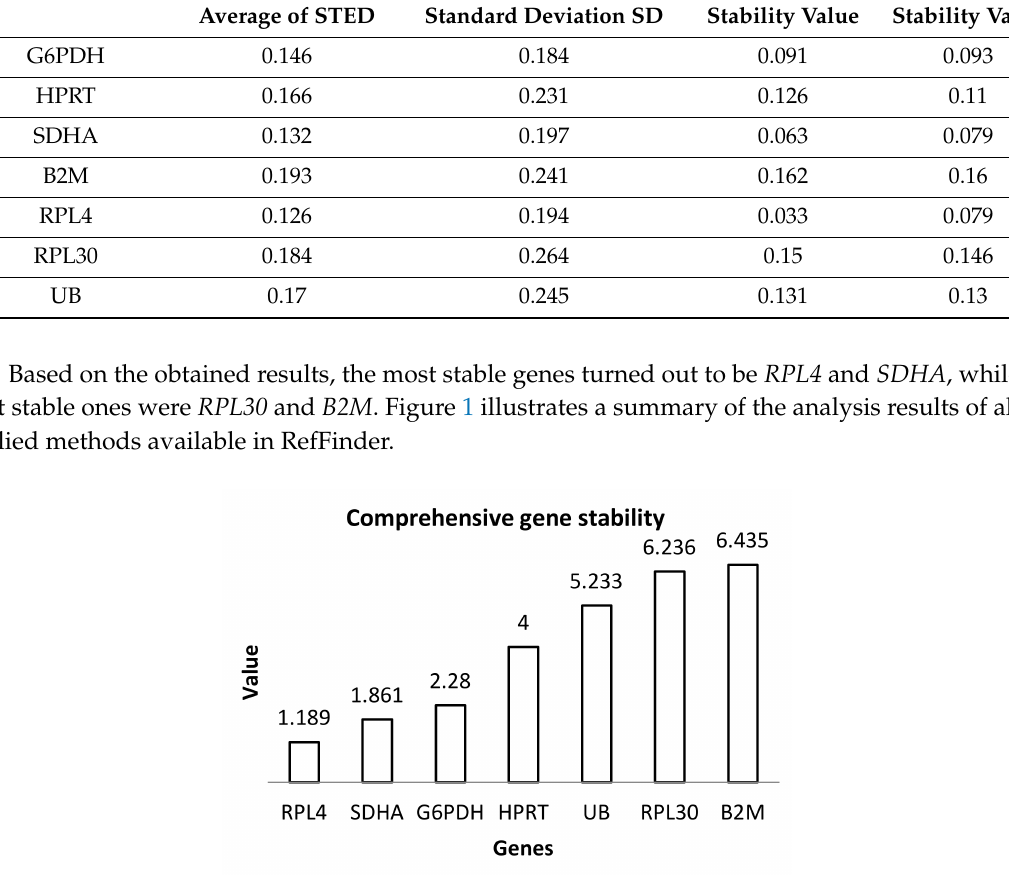
Figure 1. Graph presenting the results of reference gene analysis taking into account all available methods in the RefFinder tool. The value calculated by RefFinder is based on raw Ct values for the